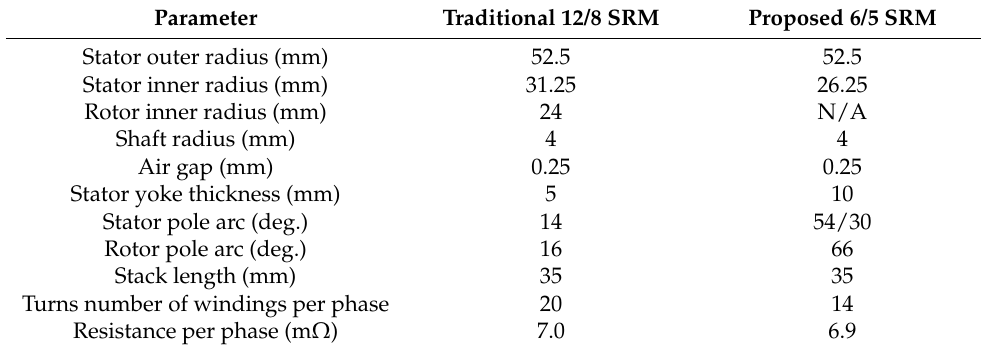
Table 1. Dimensions of traditional and proposed SRMs.